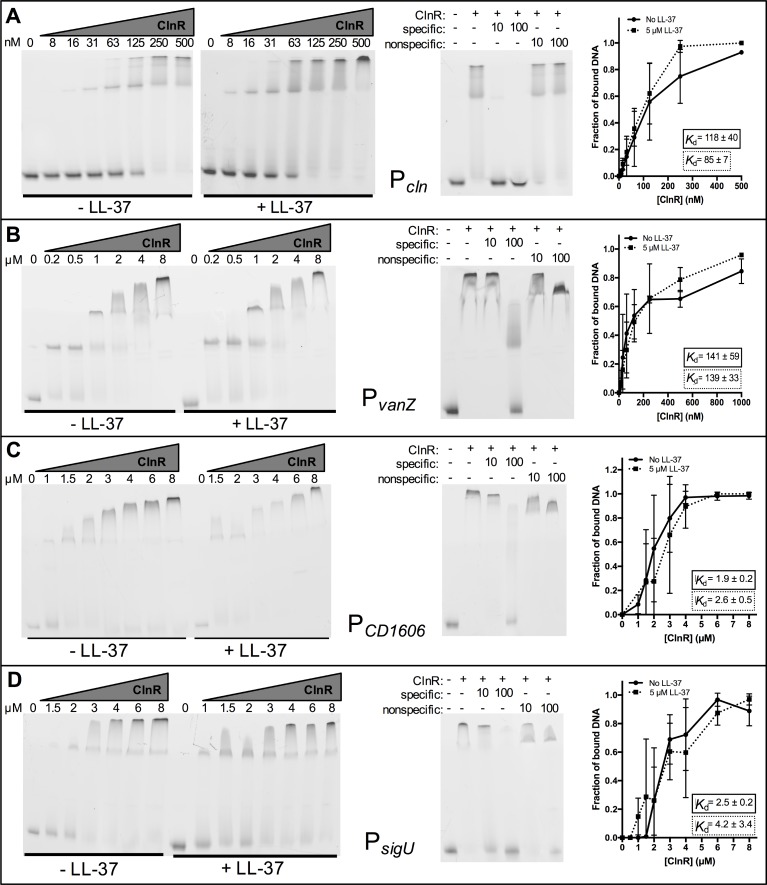
ClnR directly and specifically binds several DNA targets.Electrophoretic mobility shift assays were performed as described in Methods using His-tagged ClnR and fluorescein-labeled DNA encompassing regions upstream of A) clnR, B) vanZ, C) CD1606, or D) sigU. ClnR was added to reactions at varying concentrations (specified in nM in A, in μM elsewhere) either without or with 0.5 μM LL-37, as indicated. Competitive EMSAs were performed with the addition of unlabeled target DNA (specific) or unlabeled Pspo0A DNA (non-specific) at either 10x or 100x the concentration of labeled target DNA. 125 nM ClnR was used for the competitive EMSA for Pcln, 8 μM for all others. Apparent Kd values were calculated as described in Methods. Graphs are the binding curves showing the mean and standard deviation from three independent replicates.